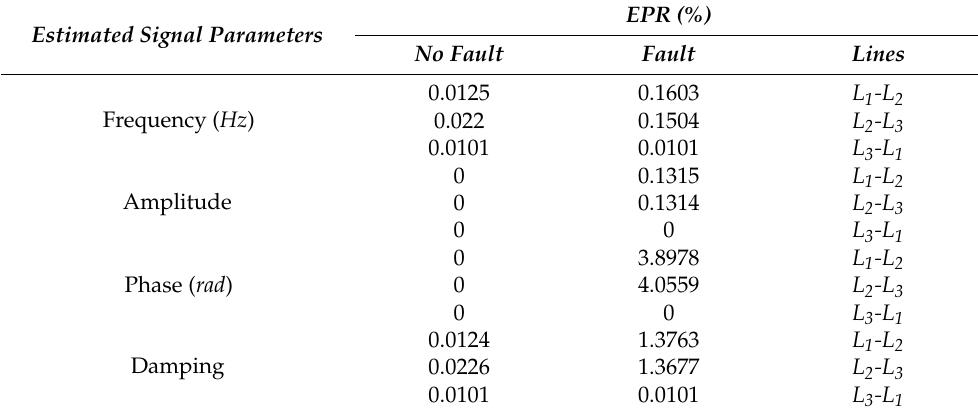
Table 3. Estimated signal parameters of simulated surge waveform (No fault and Fault).